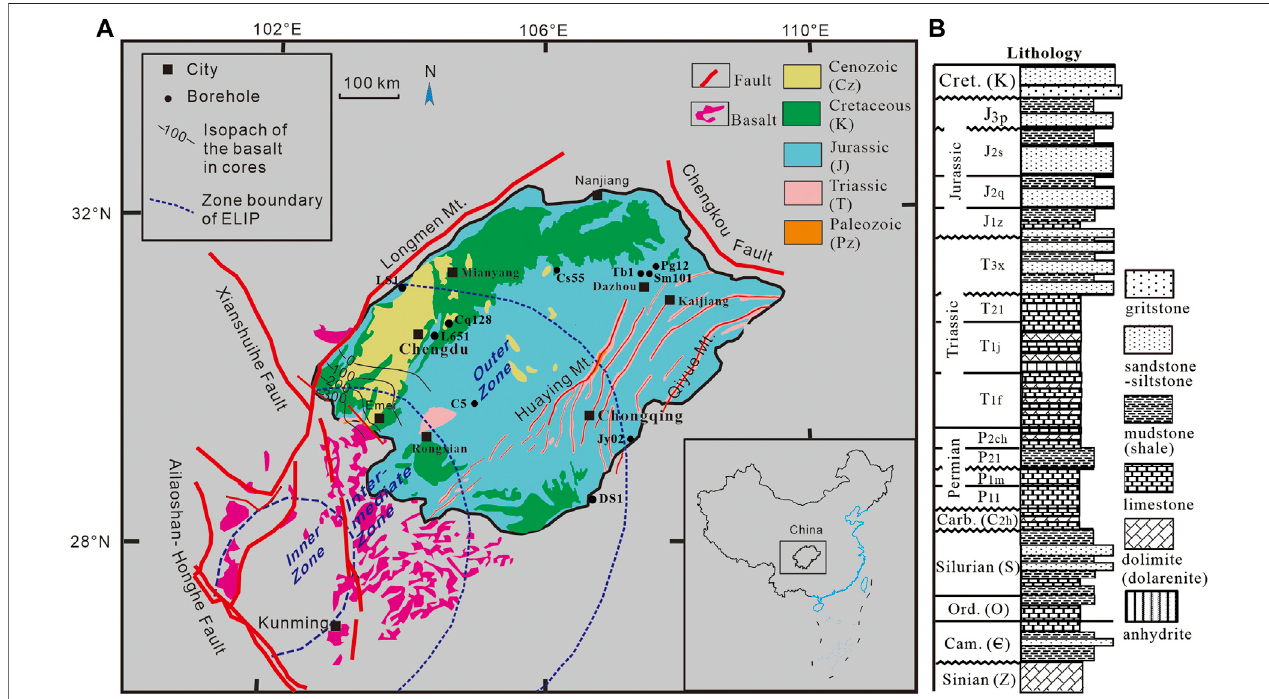
FIGURE 1 | (A) Geological setting and the location of wells which have steady state temperature logging data in the Sichuan Basin (the temperature data were publishedbyXuetal.,2011andLietal.,2017)and (B) stratigraphichistogramofthestudyarea.ThegeologicalmapwasbasedonZhuetal.(2018a);Zhuetal.(2018b), the distribution and zoning of the Emeishan Large Igneous Province (ELIP) was based on He et al. (2003), He et al. (2007), basalt thickness of the wells in Southwestern Sichuan was based on Zhang et al. (2006) and the lithological column was modi fi ed from Rao et al. (2011).